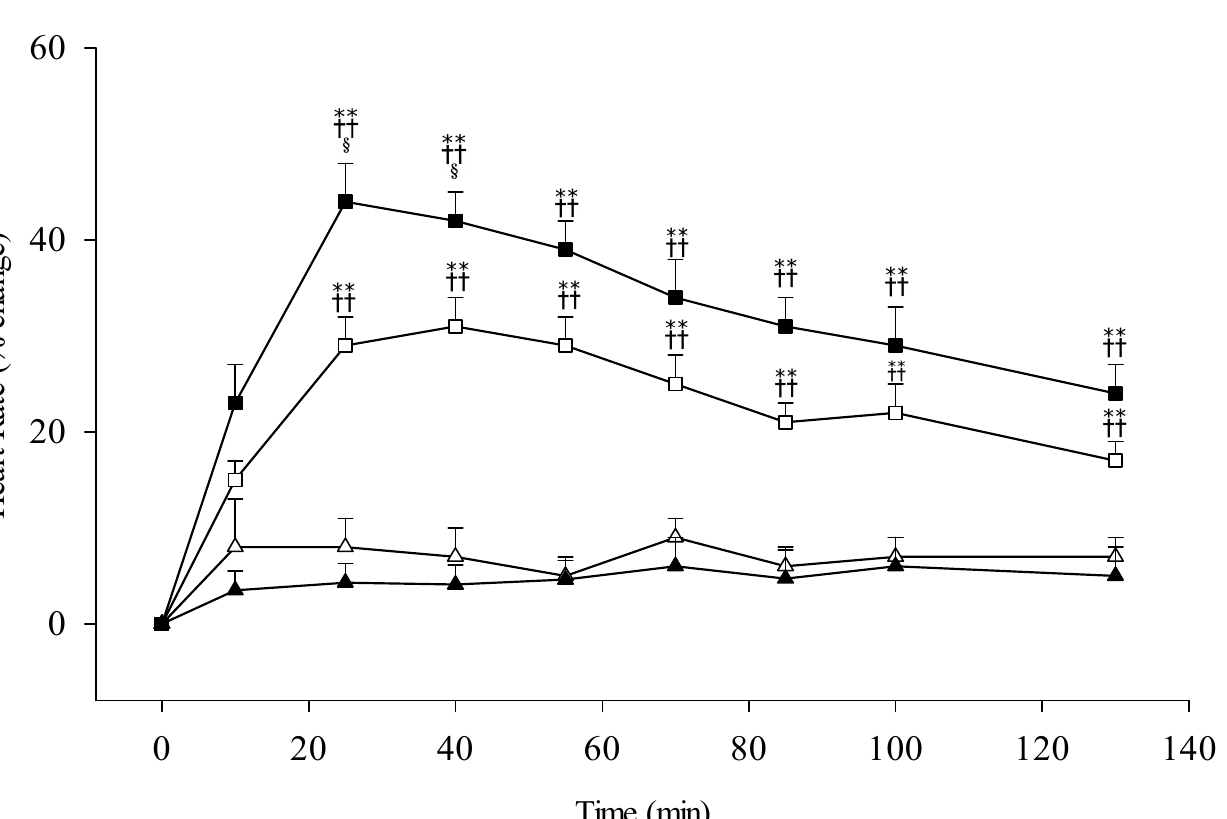
Figure 3. Percentage change of heart rate in subjects with different ALDH2 allelotypes following different doses of ethanol (0.3 g/kg body weight or 0.5 g/kg). All subjects are ADH1B*2/*2 homozygote. The study groups are denoted as △ , ALDH2*1/*1 with 0.3 g/kg ethanol ( n = 23); ▲ , ALDH2*1/*1 with 0.5 g/kg ethanol ( n = 21); □ , ALDH2*1/*2 with 0.3 g/kg ethanol ( n = 27); ■ , ALDH2*1/*2 with 0.5 g/kg ethanol ( n = 22). Vertical bars (for clarity only the upper or lower portion shown) represent standard errors of the mean. Statistically significant differences between groups at the correspond- ing time points was evaluated by ANOVA. ** p < 0.01 vs. ALDH2*1/*1 with 0.3 g/kg ethanol; ++ p < 0.01 vs. ALDH2*1/*1 with 0.5 g/kg ethanol; § p < 0.05 vs. ALDH2*1/*2 with 0.3 g/kg ethanol.